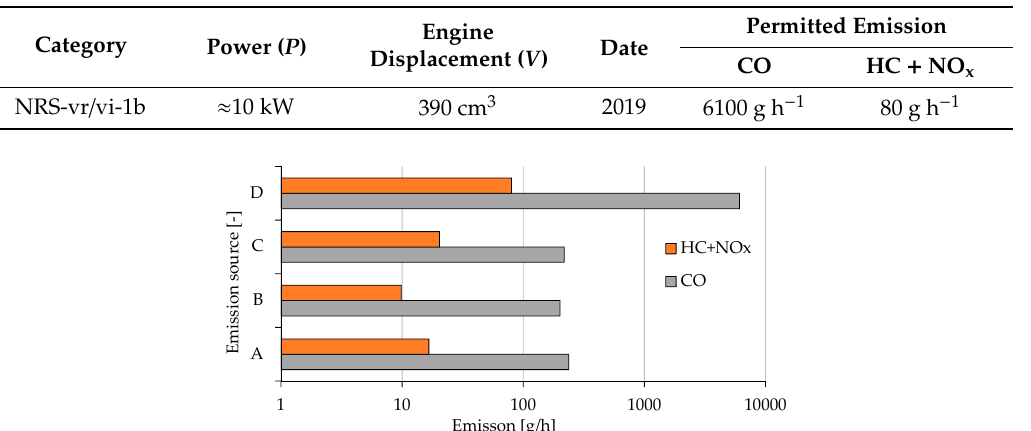
Table 8. Theoretical permitted exhaust emissions in the European Union for 10 kW engines during an hour of operation.